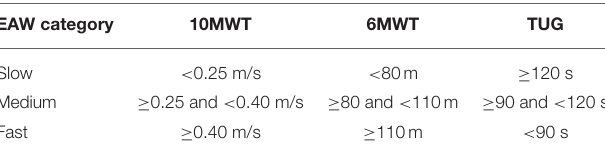
TABLE 2 | Exoskeletal-assisted walking velocity categories for each of the walking